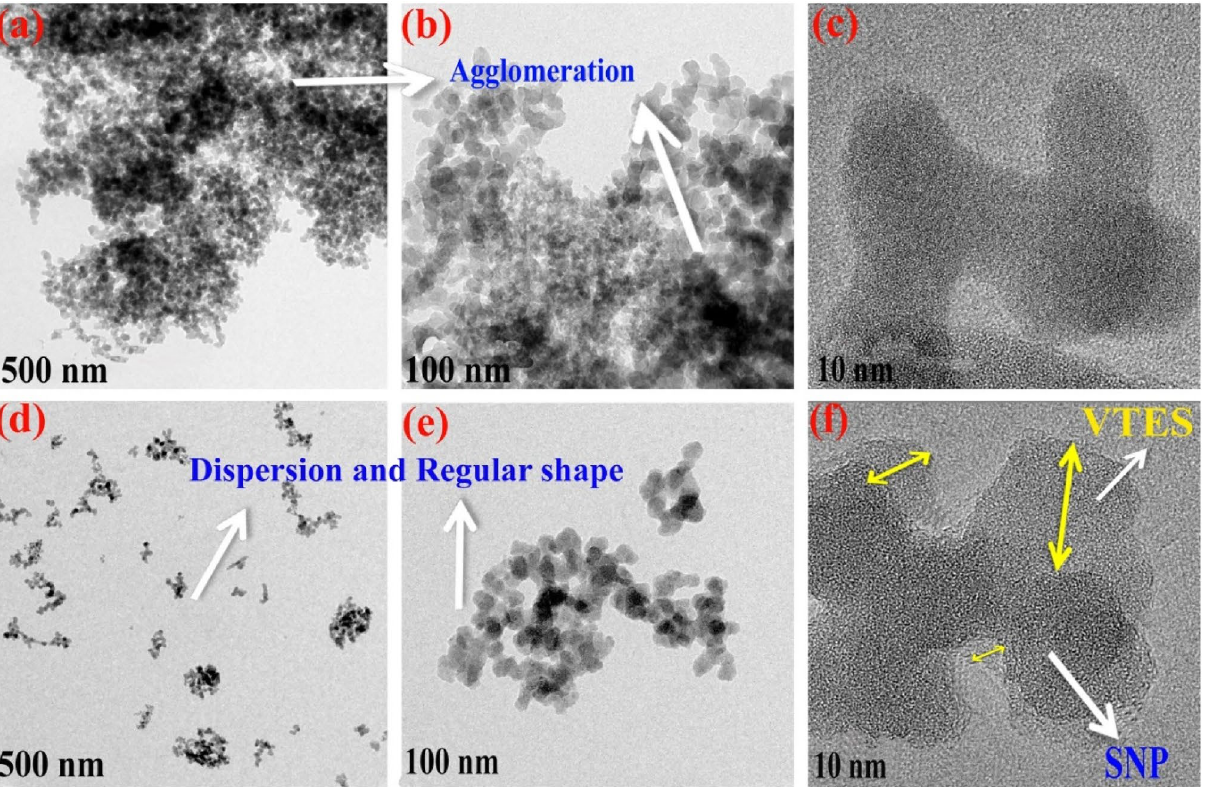
Figure 3. HR-TEM images of the silica nanoparticles; ( a – c ) Pure nano silica and ( d – f ) VTES grafted nano silica.